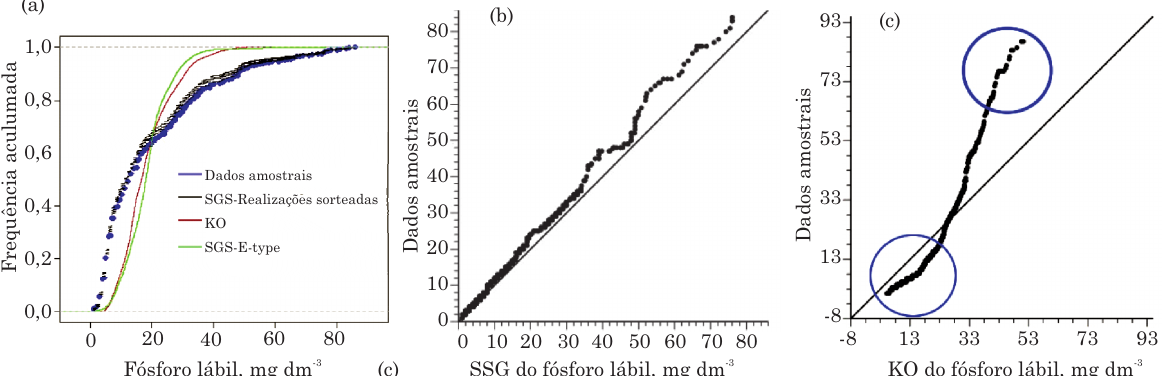
Figura 5. Funções densidade acumulada condicional do fósforo lábil (a); gráfico Q-Q do fósforo lábil: dados amostrais vs SSG (b); e dados amostrais vs KO (c).